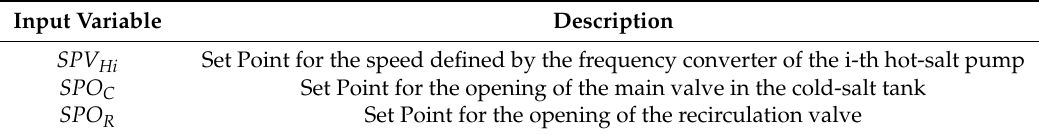
Figure 4. Process block associated to TES discharging. Table 1. TES Discharging Input Variables.